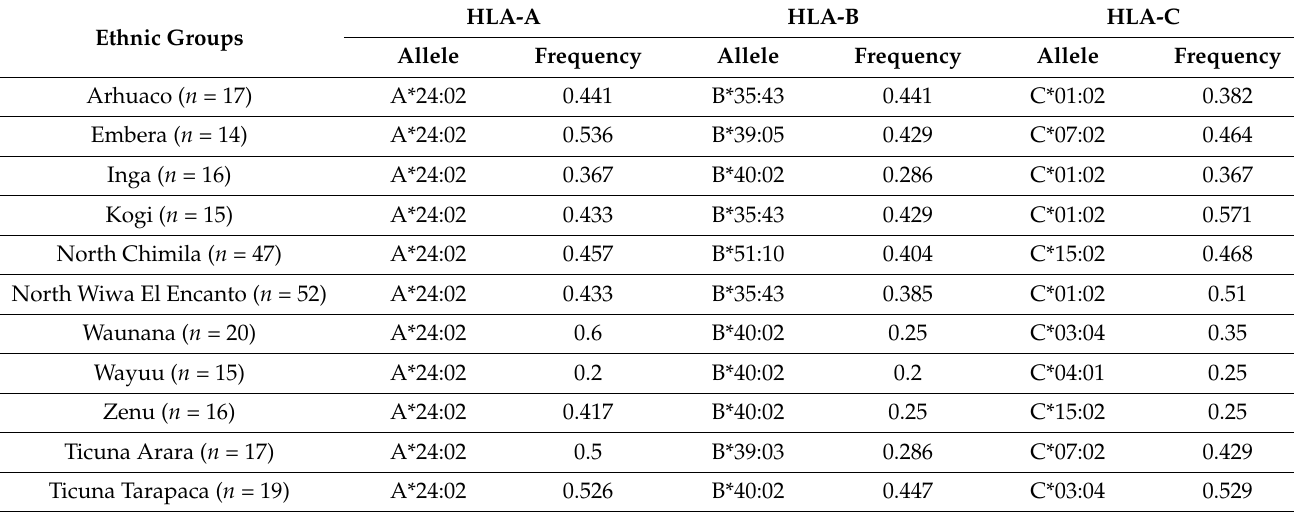
Table 6. HLA-A, HLA-B and HLA-C alleles with the highest frequency in each Colombian Amerindian groups reported in the Allele frequency net database (AFND) [28] (date consulted: 24 February 2021). Abbreviations: Abbreviations: n , sample size; PDB, Protein Data Bank Identifier.